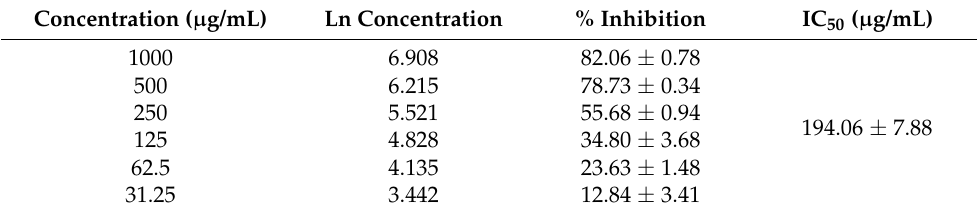
Table 2. Absorbance measurement in DPPH assay of the title compound. Concentration ( µ